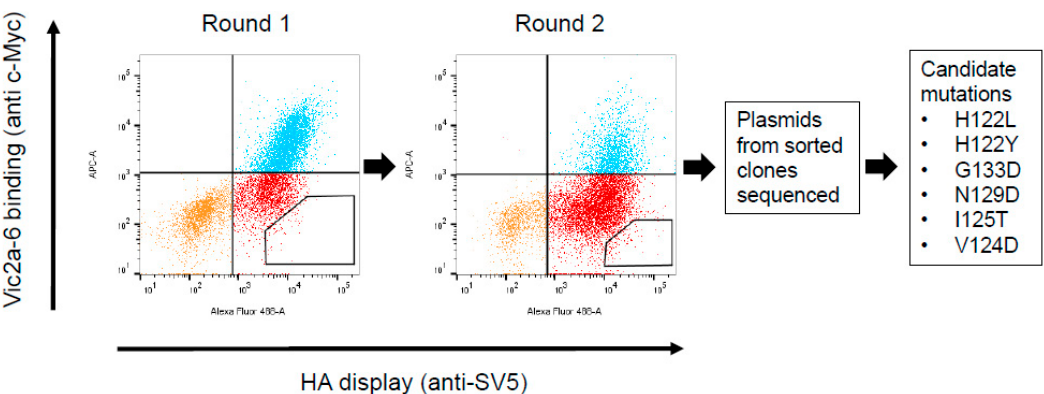
Figure 3. Cell sorting and isolation of candidate mutations interfering with the Vic2a-6 sdAb binding. Flow cytometry plots for two rounds of negative sorting for loss of binding to Vic2a-6, by gating cells in the lower right quadrant of the FACS dot plot, as indicated. Plasmids from the sorted yeast clones were sequenced and mutations in the HA which interfered with sdAb binding to HA, were identified. Residue numbering was according to B/HongKong/8/73 [29].